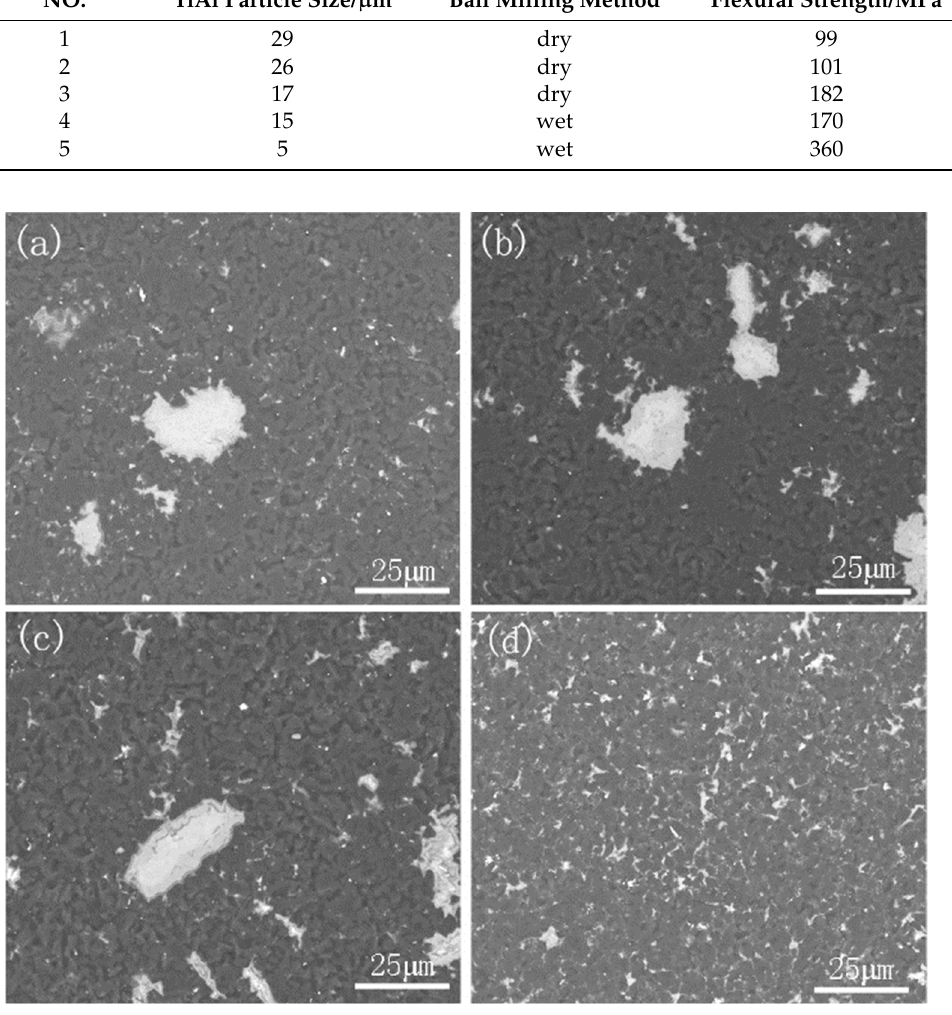
Figure 8. Backscattered electron images of cBN composites: ( a ) 29 μ m, ( b ) 17 μ m, ( c ) 15 μ m, ( d ) 5 μ m.